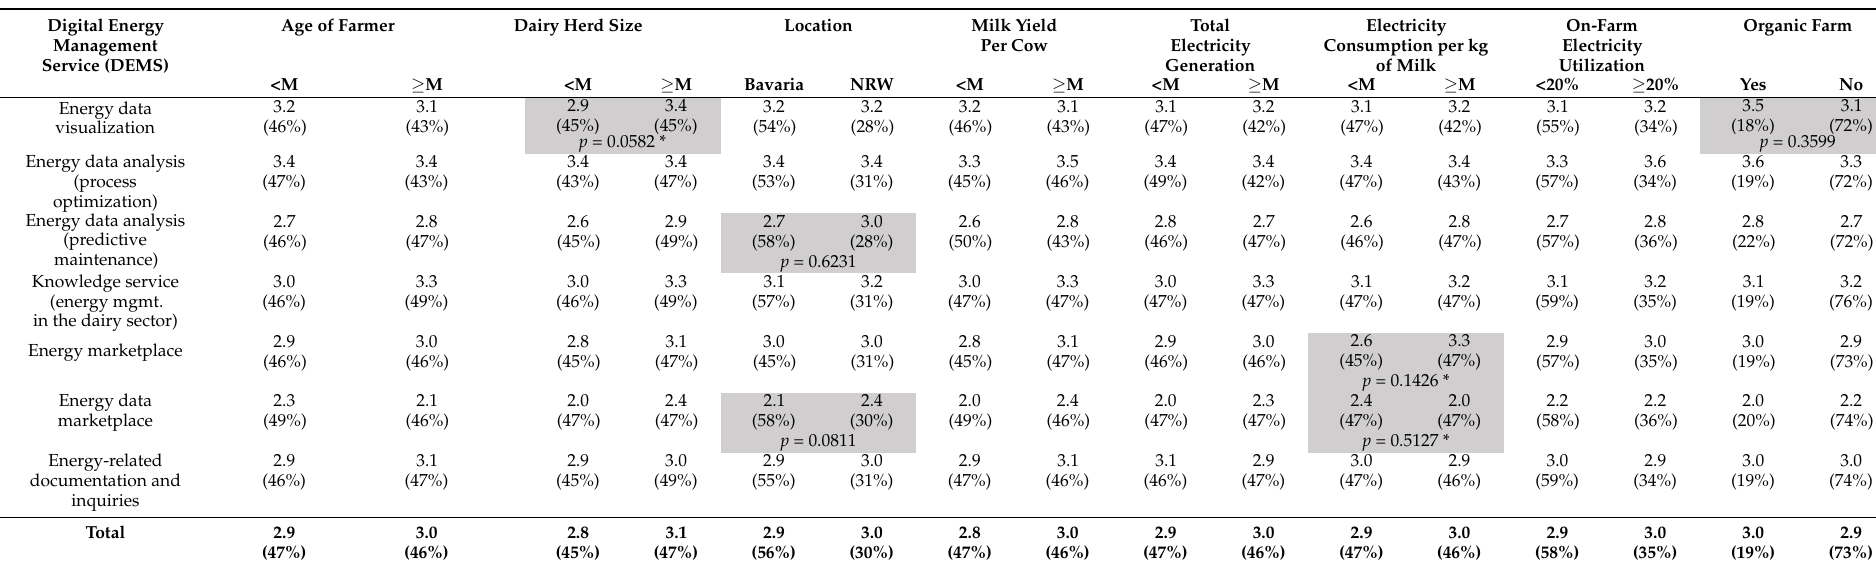
Table 2. Stated relevance of DEMS dependent on farm characteristics (translated and simplified), including information on the sample share and the p -Value in selected data